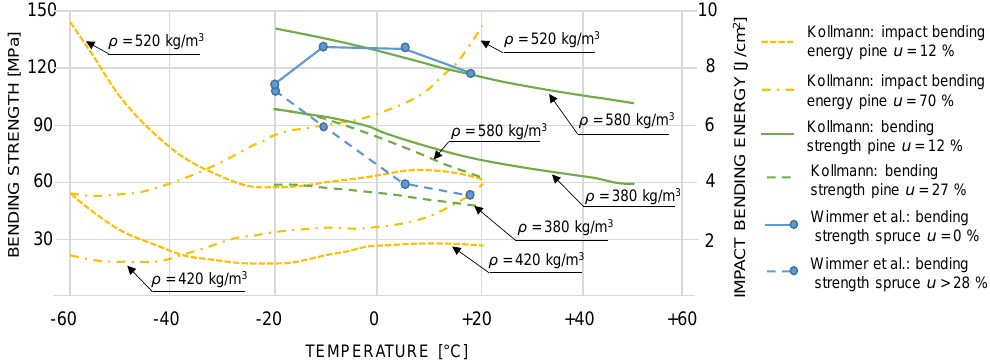
Figure 1. Overview of the mean bending strength and mean impact bending energy values of spruce and pine vs. temperature and at varying moisture contents and densities.